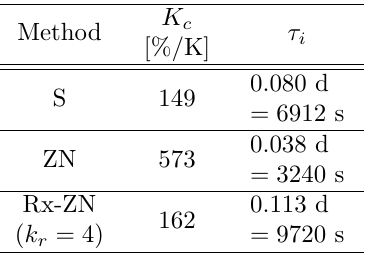
Table 2: Results with various PI tuning methods for the real temperature control system: S = Sko- gestad. ZN = Ziegler-Nichols. R-ZN = Re- laxed